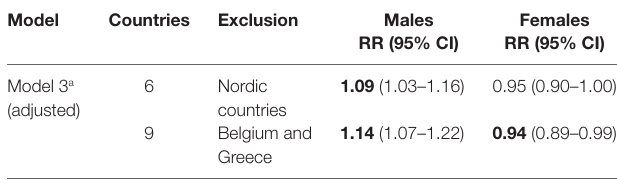
TaBle 3 | Sensitivity analysis of the association between life expectancy and renal replacement therapy prevalence depending on the selection of countries.